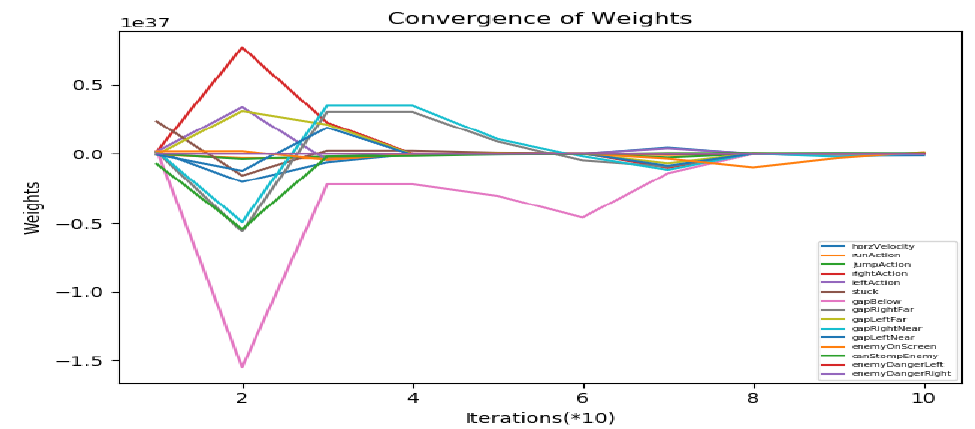
Figure 12. Approx Q-learning agent: Plot for convergence of weight. Notable fluctuations before convergence at around 80